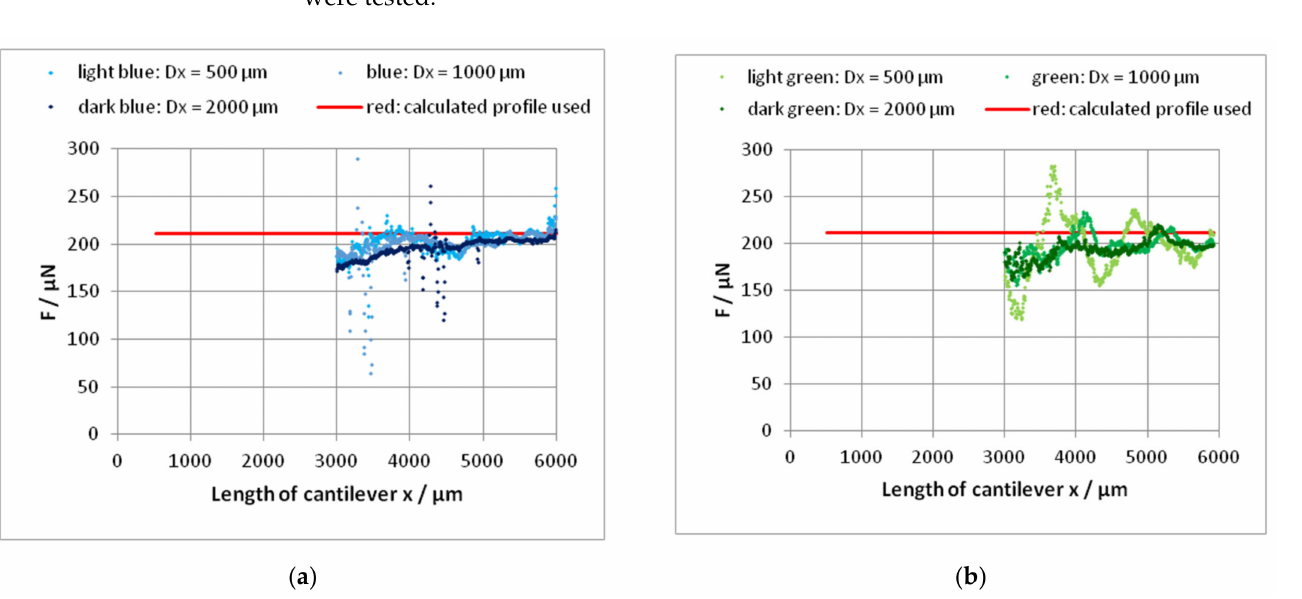
Figure 12. Determination of the stylus force from a tactile measured profile (zero load corrected) of the cantilevers 45-1 ( a ) and 70-4 ( b ) using the difference method after Equation (8); ∆ x : 500 µ m; 1000 µ m; 2000 µ m. The red lines result from a function z ( x )= a · x 3 fitted at the base of the measured values; see Table